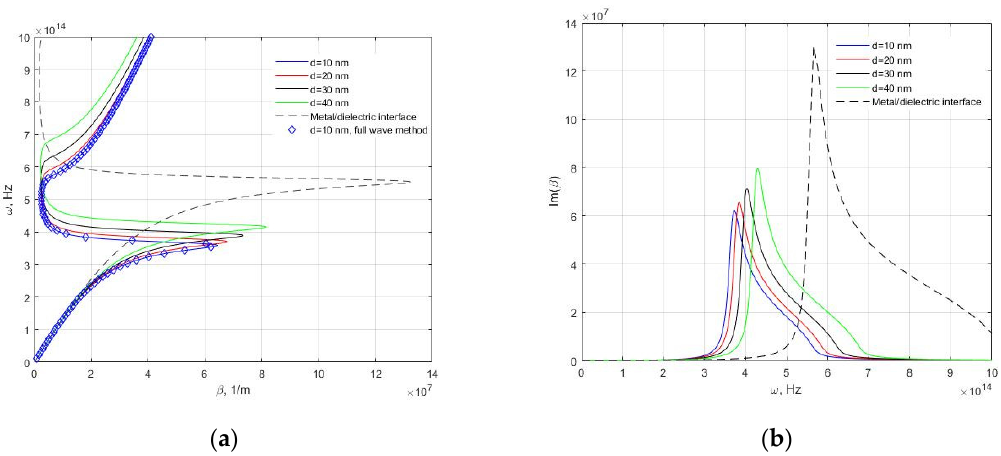
Figure 4. Mode patterns of the surface waves at the interface of metamaterial and dielectric ( ε d = 11.8). S = 70 nm. Dependencies of the real ( a ) and imaginary ( b ) parts of the propagation constant, upon frequency.